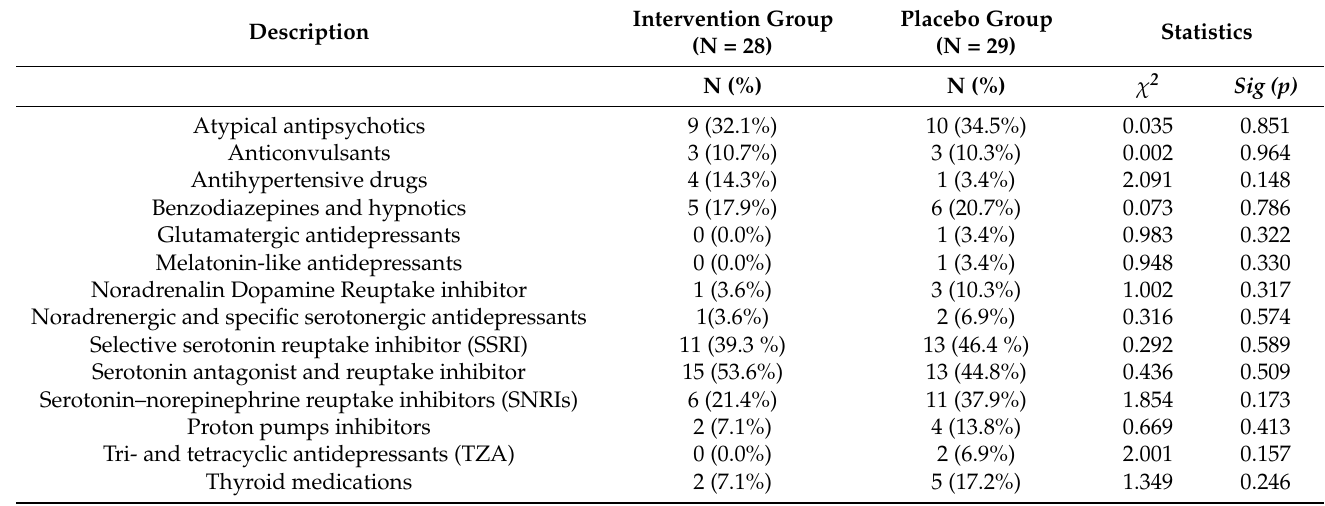
Table 2. Description of the pharmacological treatment of PROVIT metabolomics at baseline.